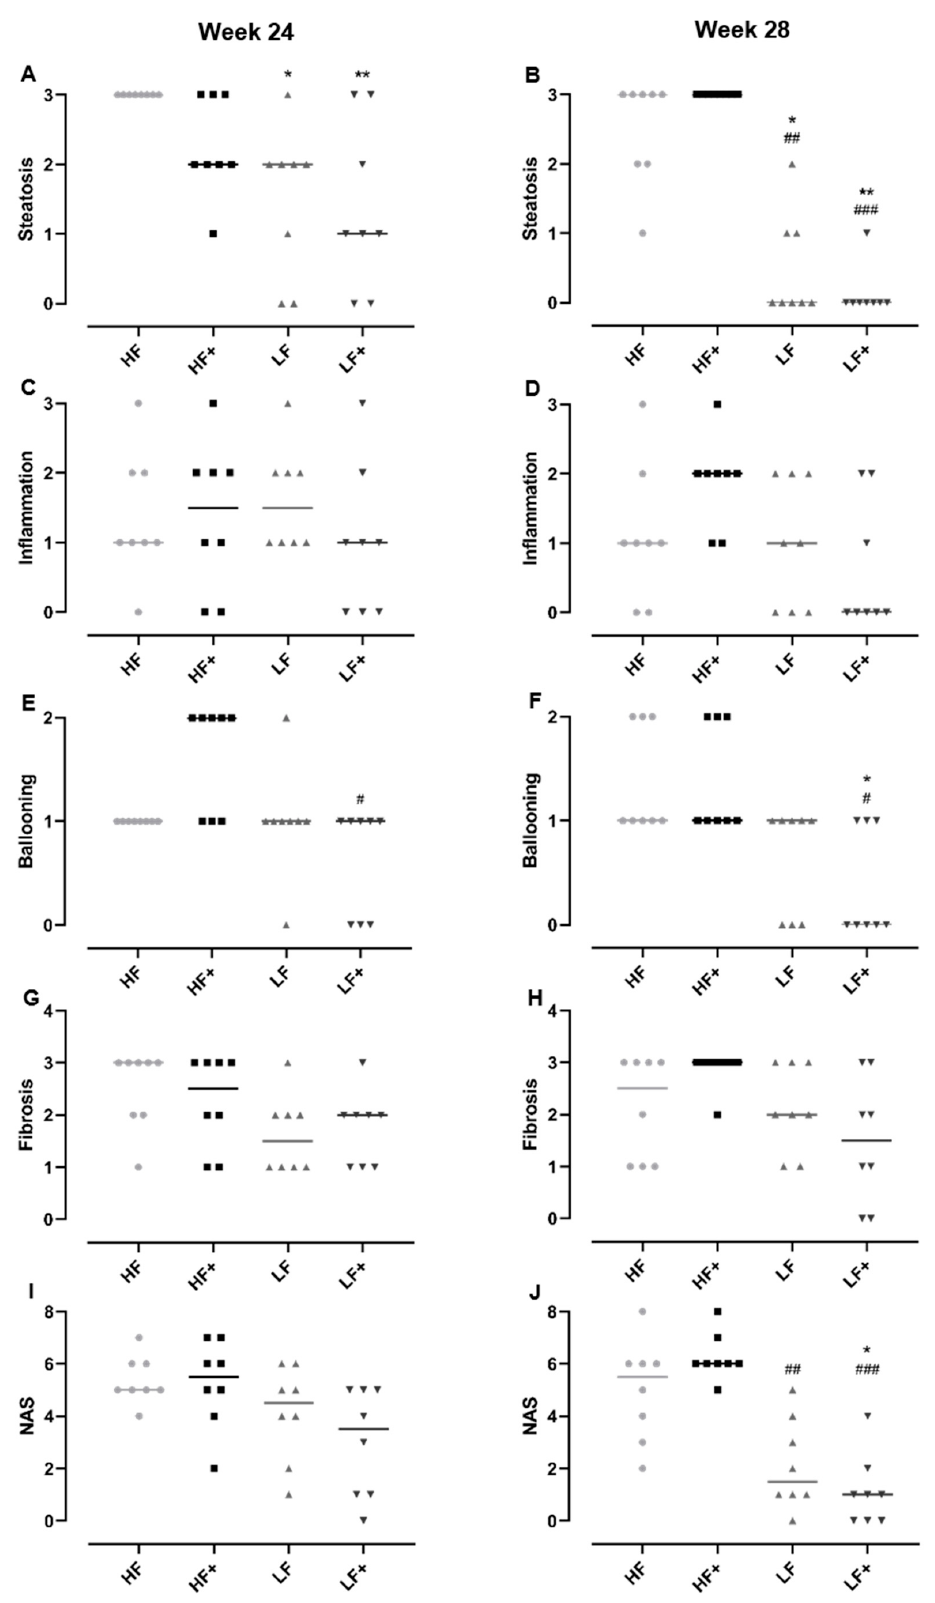
Figure 4. Histopathological scoring by the NAFLD activity scoring system and evaluation of disease severity. ( A , B ) Dietary intervention (LF) and dietary intervention combined with atorvastatin and vitamin E (LF+) reduced hepatic steatosis compared to HF (after 24 and 28 weeks) and HF+ (after 28